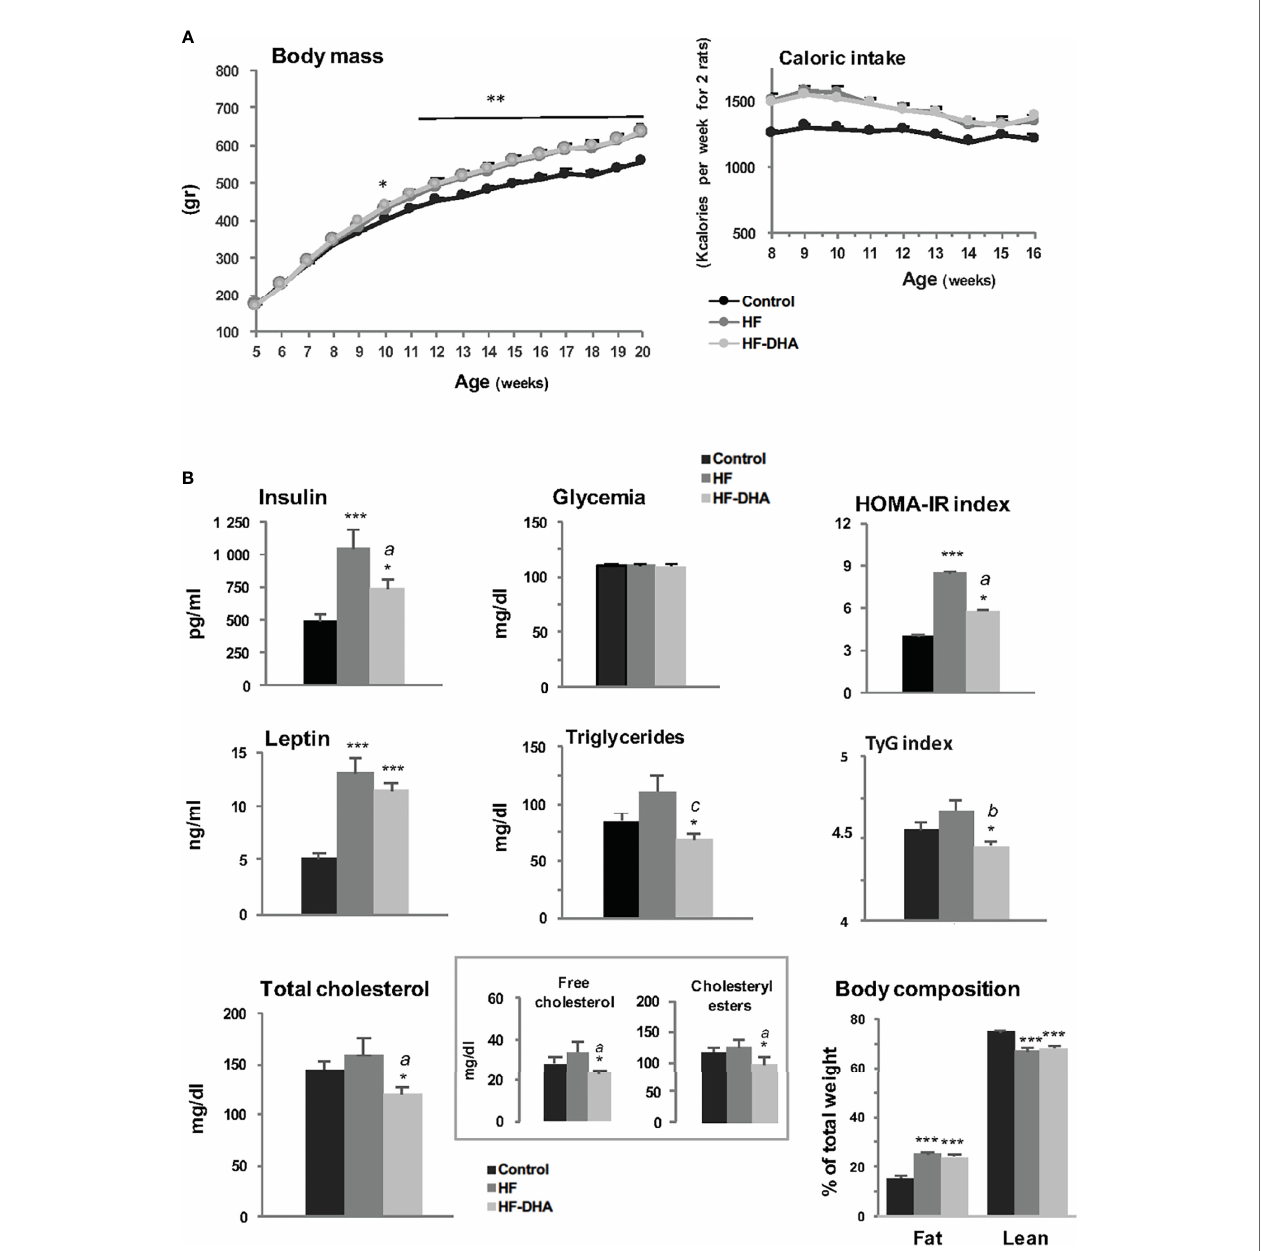
FIGURE 1 | Metabolic status of male rats fed high-fat diets. (A) Body mass and caloric intake of male Wistar rats fed control (8.5% kcal from fat) or high-fat (45% kcal from fat) diets supplemented (HF-DHA) or not (HF) with 5% DHA. (B) Fasting plasma levels of insulin, leptin, glucose, triglycerides and cholesterol (total, free and esteri fi ed forms) and body composition (% fat and lean mass) were measured after 11 weeks of diets. The body composition was measured with the Echo MRI ™ system. HOMA-IR and TyG indexes were calculated as a re fl ect of insulin resistance. Data are expressed as means ± SEM (n= 12 rats) and were analyzed with one- way ANOVA followed by Tukey ’ s multiple comparison test. * P ≤ 0.05; ** P ≤ 0.01; *** P ≤ 0.001 vs control. a P ≤ 0.05; b P ≤ 0.01; c P ≤ 0.001 between HF and